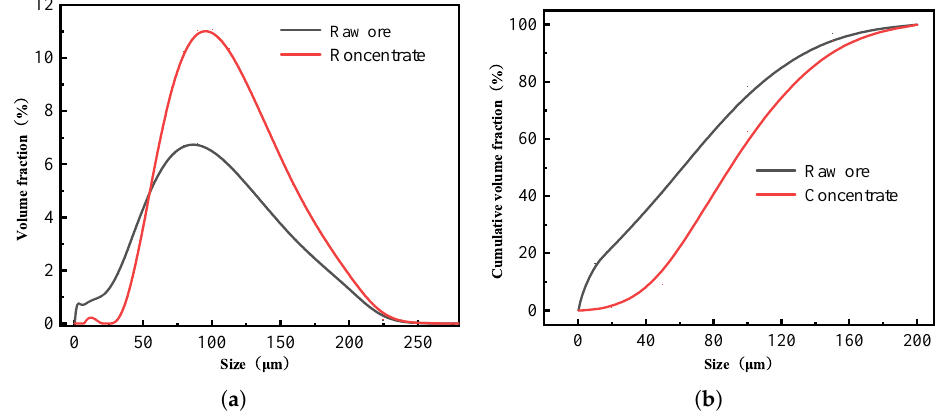
Figure 7. Comparison of laser particle size. ( a ) Volume fraction, ( b ) Accumulated points.